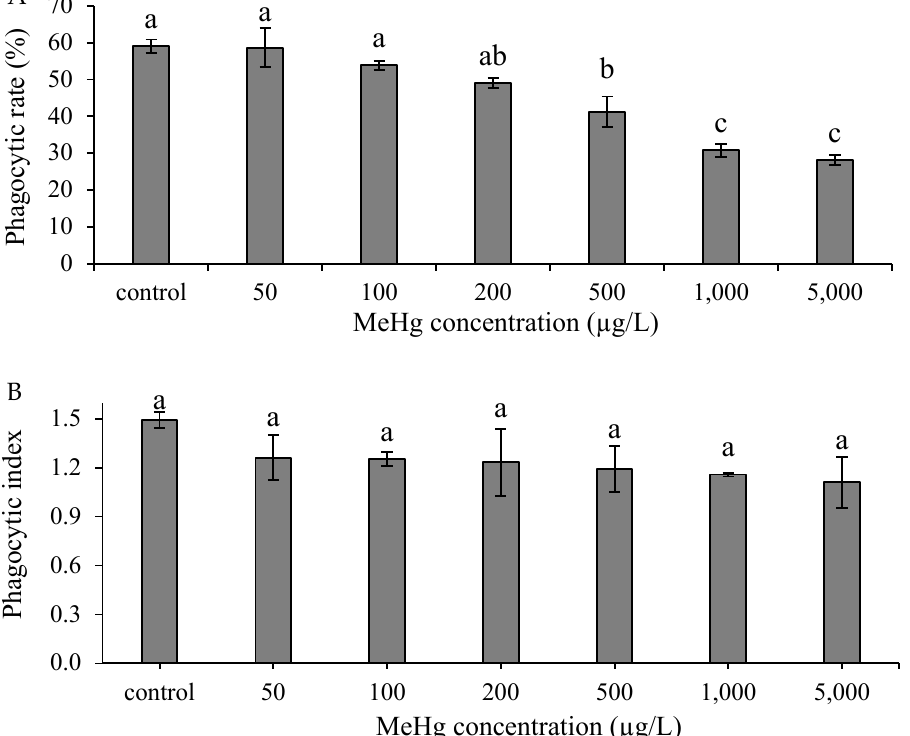
Figure 2. Phagocytic rate ( A ) and phagocytic index ( B ) of hybrid grouper leukocytes after in vitro incubation with various concentrations of methylmercury for 30 min. One-way ANOVA and Tukey’ test were performed to compare the differences between groups. Values are presented as mean ± SD ( n = 3). Significant differences ( p < 0.05) between treatment groups are indicated by different letters above the bars.